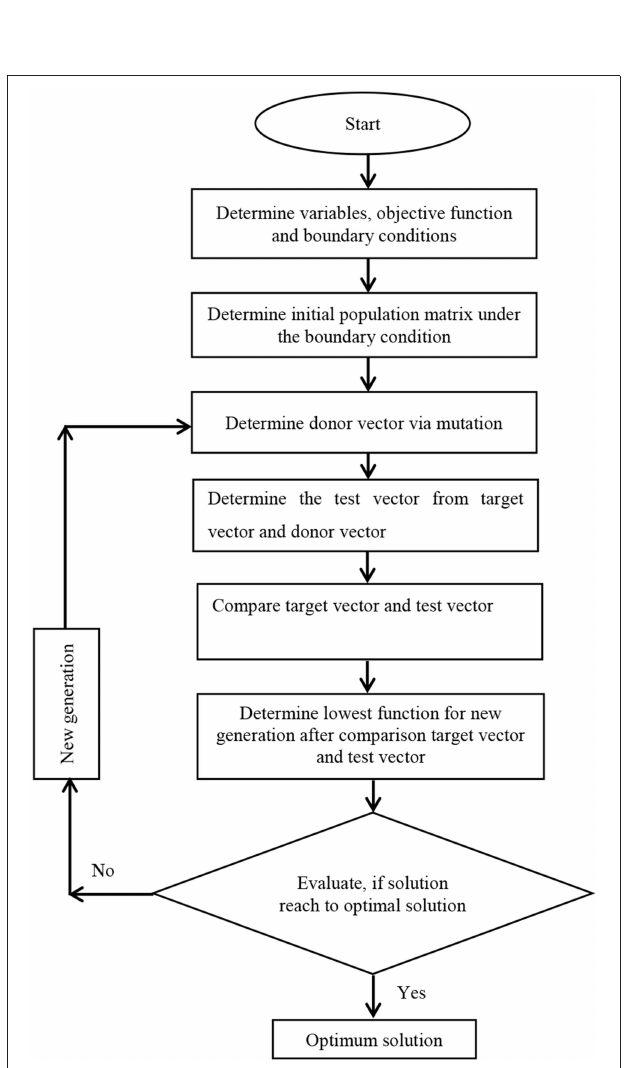
FIGURE 2 | Differential Evaluation Flowchart.